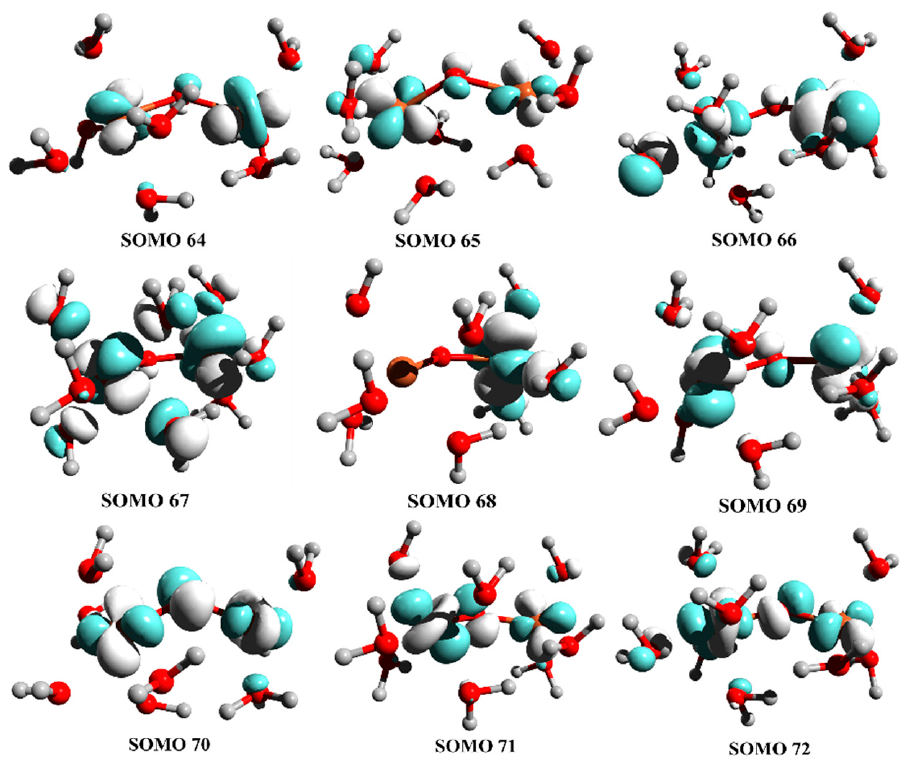
Figure 6. Singly occupied molecular orbitals (SOMO) in high-spin state with S = 9/2. A more simplified structure was used, in which the negative oxygen charge was neutralized by hydrogen atoms.